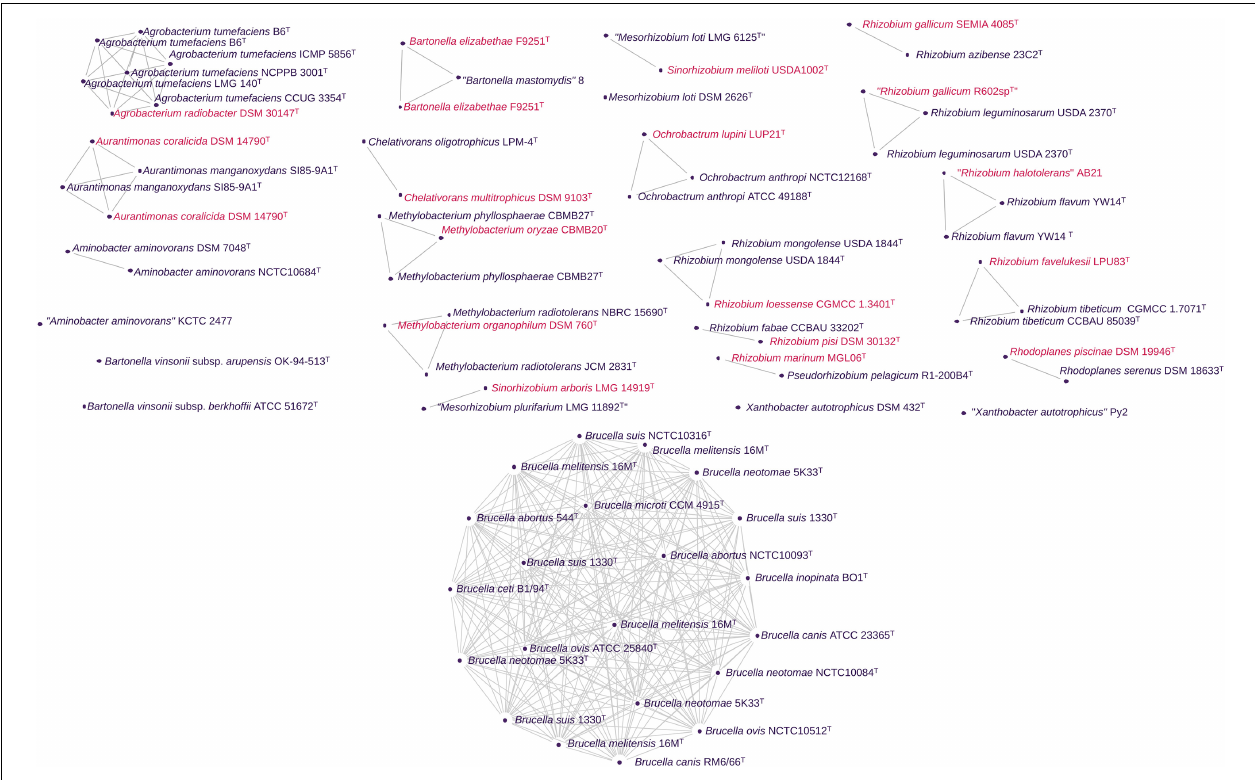
FIGURE 3 | Genomic clusters detected using pairwise ANI values from 520 Rhizobiales genomes. Here, only a subset is shown following filtering to (i) retain genomes clusters containing more than one bacterial species name and (ii) the unconnected genomes containing the same species names (synonym strains). In the graph, the clusters have nodes corresponding to genomes and edges corresponding to ANI values above the cut-off for species delineation. In the case of ANIb from pyANI, where an alignment coverage matrix was also generated, the edges additionally correspond to a reliable alignment of between the set of genomes. The same graph structure was obtained using FastANI values. Different colors were used whenever possible to indicate different species